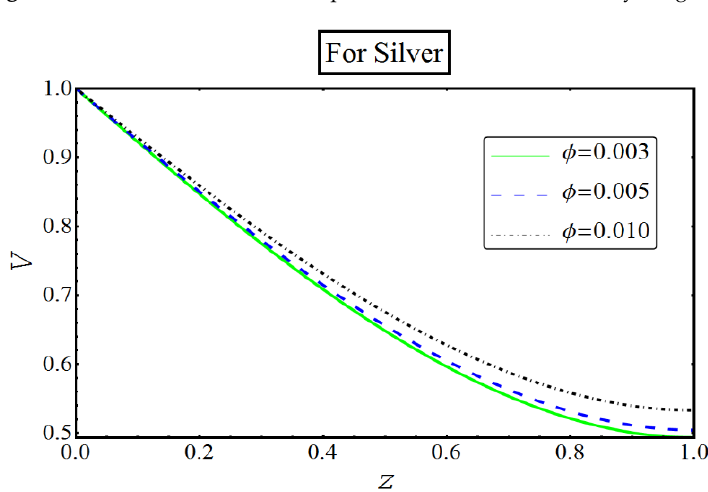
Figure 19. Effects of concentration particles suspended with ethanol on 𝑁 for silver.